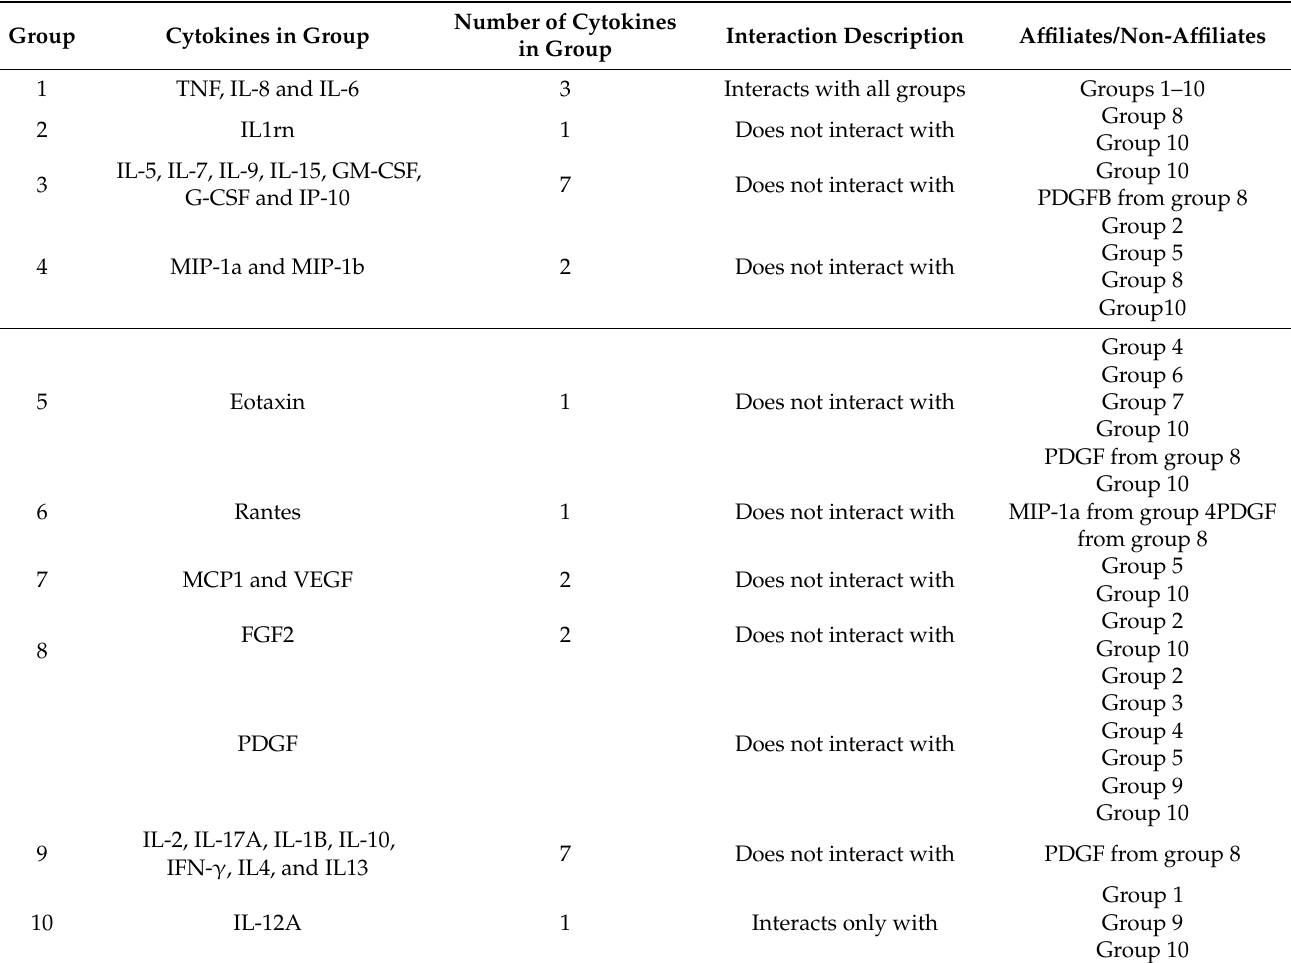
Table 2. Cytokine grouping based on cluster interactivity similarity across network, showing 10 dis- tinct groups with various levels of directed and noninteraction with other group